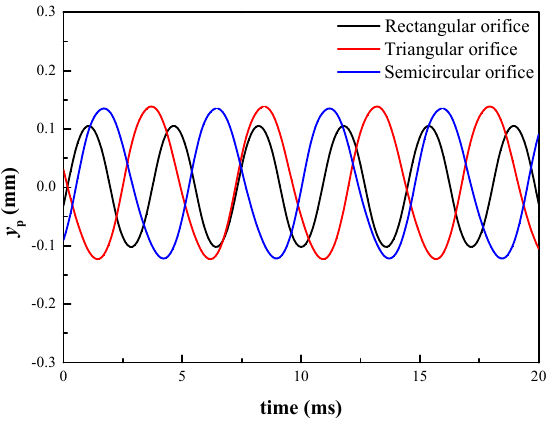
Figure 21. Displacements of different orifice shapes.